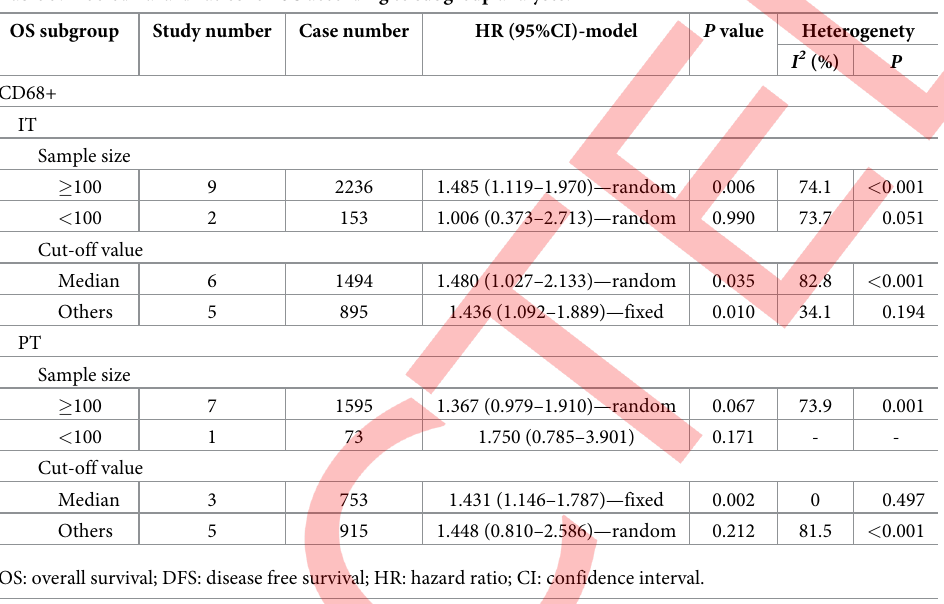
Table 3. Pooled hazard ratios for OS according to subgroup